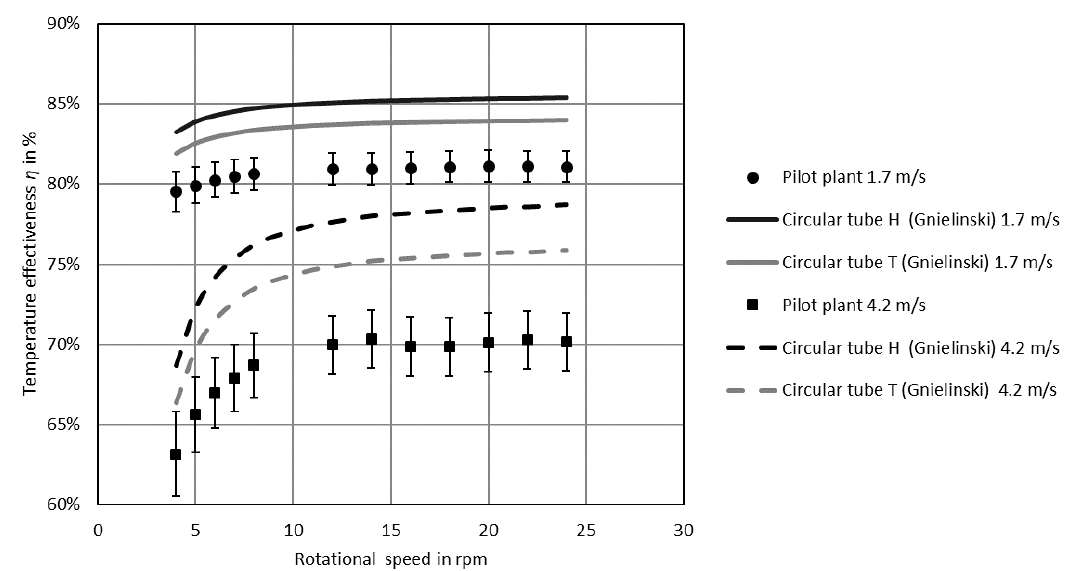
[33]. The simulation results with the newly proposed LINUS model (with H1 and T boundary conditions, labeled hereafter as the LINUS model) are compared to the results from the pilot plant: Figure 13. Results from pilot plant and simulation with circular tube models reported by Gnielinski [33]. The average difference between the experimental results and the T model from Gniel- inski [33] is +3.8% points. This model shows the same slope of logarithmic growth as the model of Shah and London, but it shows much higher temperature effectiveness. Since an